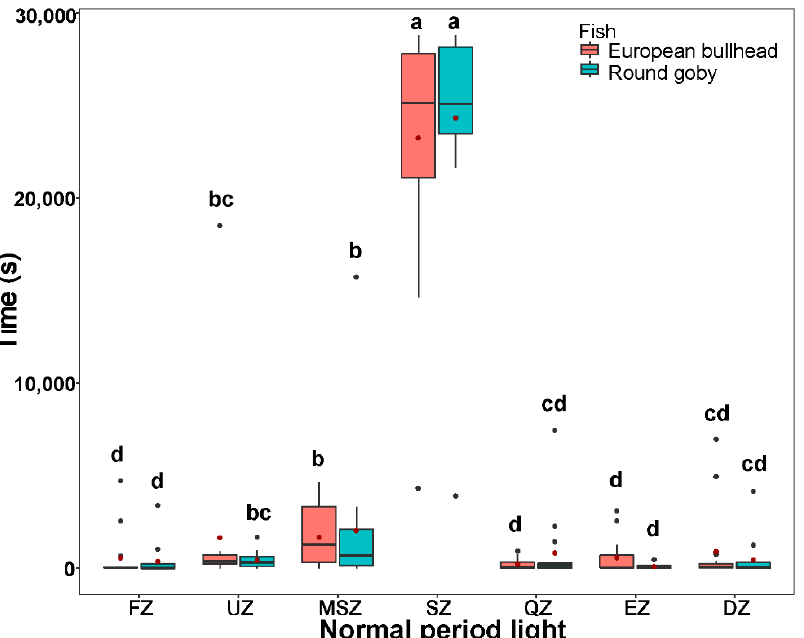
Figure 3. The time spent by Cottus gobio (red) and Neogobius melanostomus (turquois) in channel zones during two periods of tracking normal behavior in darkness (upper box plot), and light (lower box plot). Box limits correspond to upper (Q3—75%) and lower (Q1—25%) quartiles, horizontal bar to the median, red dot to the mean, outliers are indicated by points (min = Q1 − 1.5 × IQR; max = Q3 + 1.5 * IQR). FZ = feeding zone, UZ = upstream zone, MSZ = mid ‐ stream zone, SZ = shelter zone, QZ = quiet zone, EZ = escape zone, DZ = downstream zone. Values with different letters indicate signif ‐ icant intraspecific differences ( α = 0.05); asterisks indicate significant interspecific differences. Table 2. The distance moved (cm), time spent outside shelter (sec and %), time spent in motion outside the shelter (sec and %), and proportion of time spent in movement (%) during the trial observed in Neogobius melanostomus (RG) and Cottus gobio (EB). SR = stress response period, EPL = exploration period in light, EPD = exploration period in darkness; NPD = normal behavior period in darkness, NPL = normal behavior period in light. Values with different letters within rows indicate significant intraspecific differences ( α = 0.05). Data are mean ± SD.